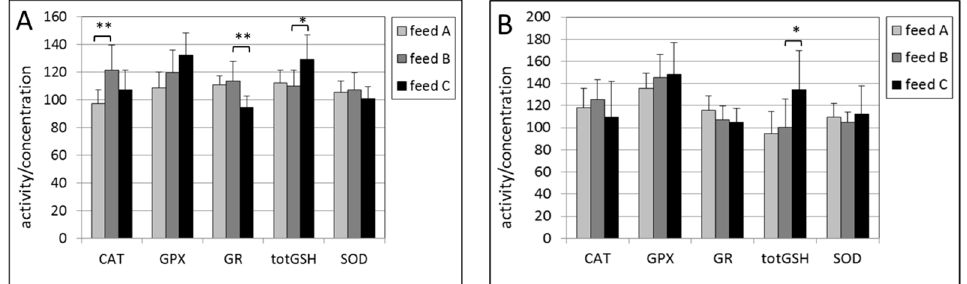
Figure 2. ( A ) Activities of catalase (CAT), glutathion peroxidase (GPX), gluthation reductase (GR), superoxide dismutase (SOD) and concentration of total glutathione (totGSH) in erythrocytes from male (Figure A); and ( B ) female mice. The levels of CAT, GPX, GR and SOD were multiplied by a factor of 10, 5, 0.3 and 2, respectively to fit in the figure. The levels of feed B were tested statistically relative to those of feed A, and the levels of feed C relative to those of feed B. * p < 0.05, ** p < 0.01.